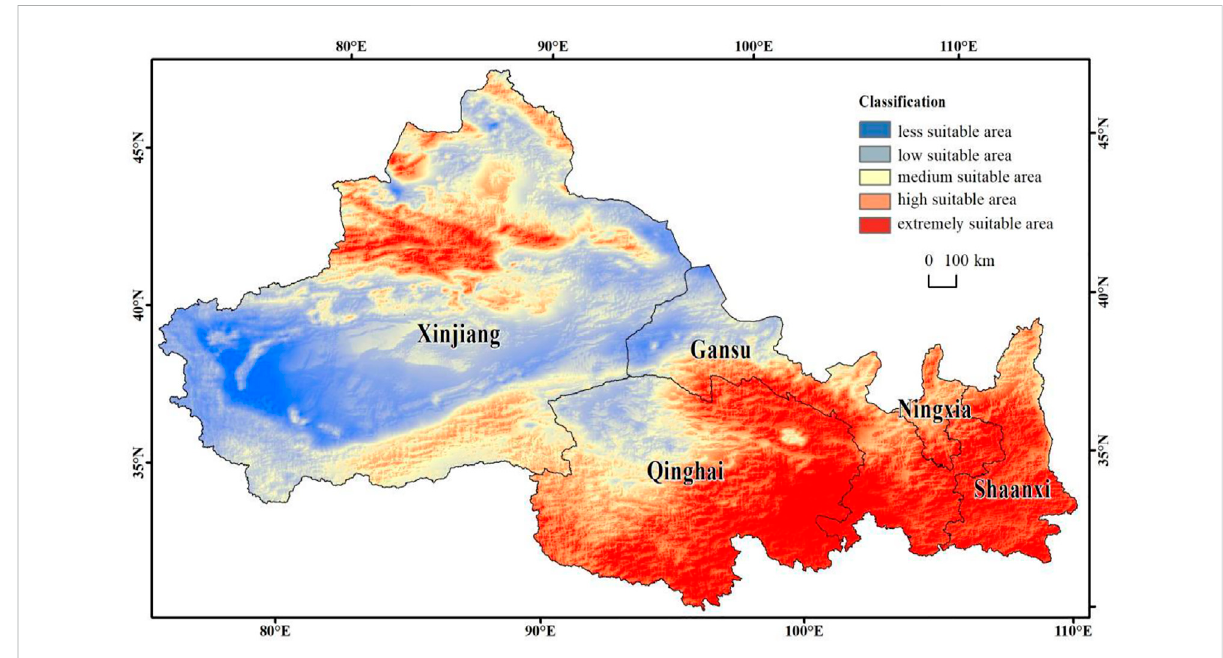
FIGURE 4 Deep learning predictions of areas in Northwest China with high potential for development as scenic